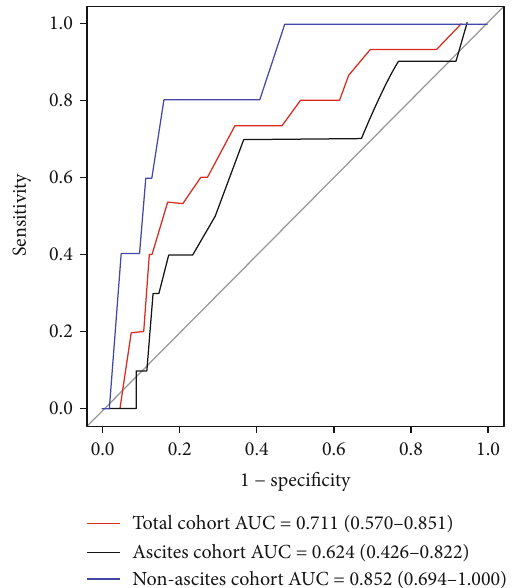
Figure 2: ROC curve of HVPG for predicting early rebleeding in the total cohort, the ascites cohort, and the nonascites cohort. AUC: area under the ROC